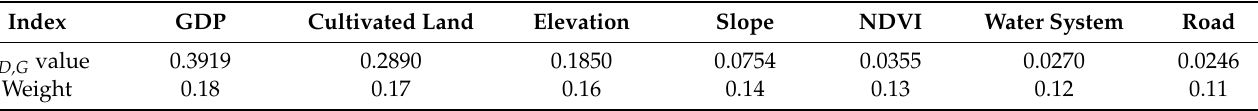
Table 2. RS-SDI index weights (RS-SDI:Rural Settlement Sustainable Development Index).